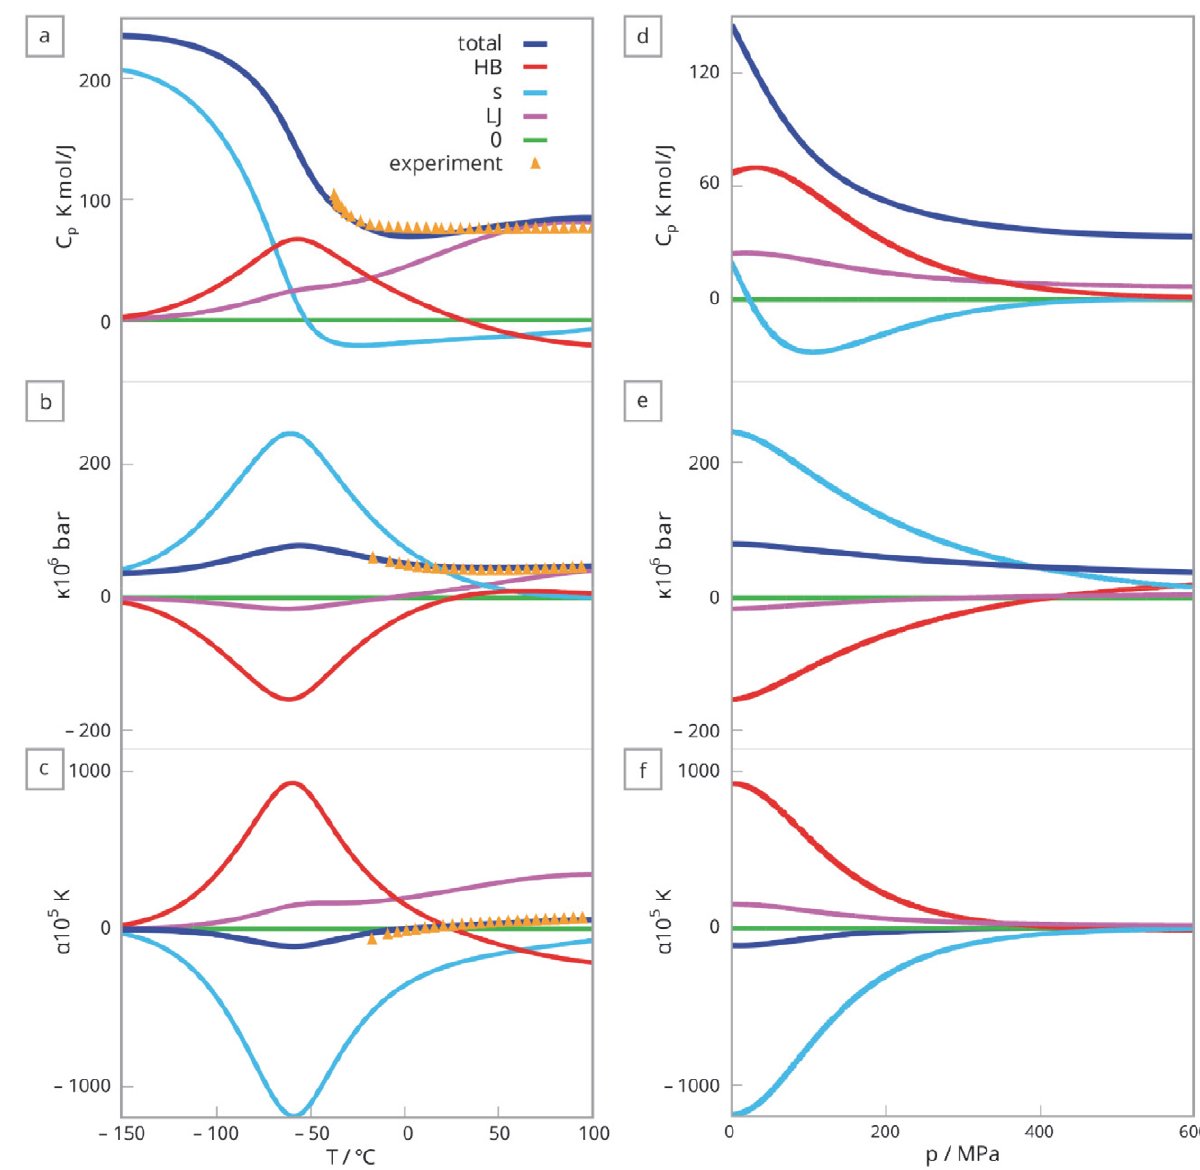
Figure 15: Molecular components of supercooled water vary with temperature and pressure. Colored lines show the components HB (pairwise H bonded), s (12-mer cages), LJ (waters in pairwise contact), and 0 (waters separated and noncontacting). Dark blue line is the sum of all components. Pressure dependence is calculated at −35 °C and temperature dependence at 0.1 MPa (1 atm). Most definitive features are the strong variations of the balance of molecular components with T and p and how strongly the caging behaviors are opposed by the pairwise hydrogen-bonded